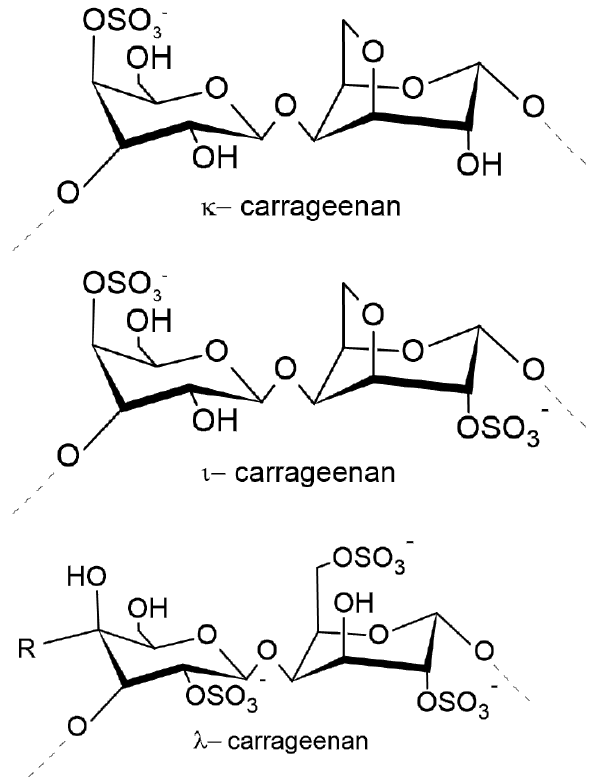
Figure 6. Chemical structures of the three types of carrageenans.